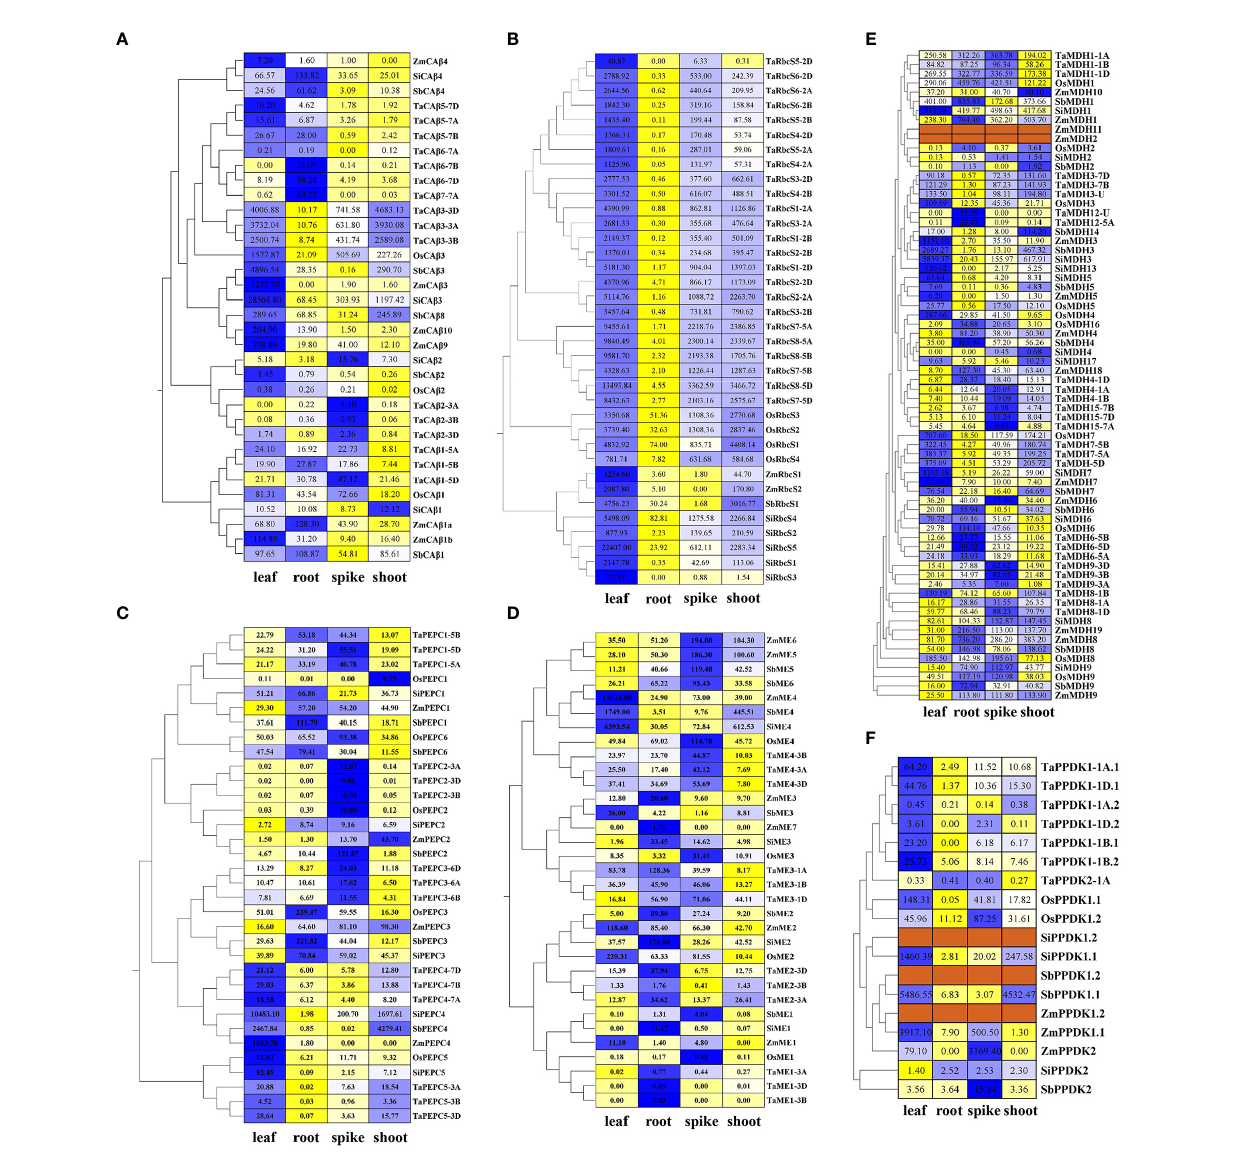
FIGURE 3 Expression levels of all putative genes encoding key C 4 photosynthetic enzymes in four tissues (leaf, root, stem, and spike) from RNA-seq data. The heatmaps were drawn based on the EL values after the normalization of different tissues, with their original FPKM values listed in the corresponding grid. All genes were clustered according to their phylogenetic relationship. The blue and yellow colours represent higher and lower relative abundance for each transcript in each sample, respectively, and the dark red colour represents no data support. Based on the special double promoter structure of PPDK, the expression levels of all transcripts are listed. (A) b -CA ; (B) RbcS ; (C) PEPC ; (D) ME ; (E) MDH ; (F) PPDK